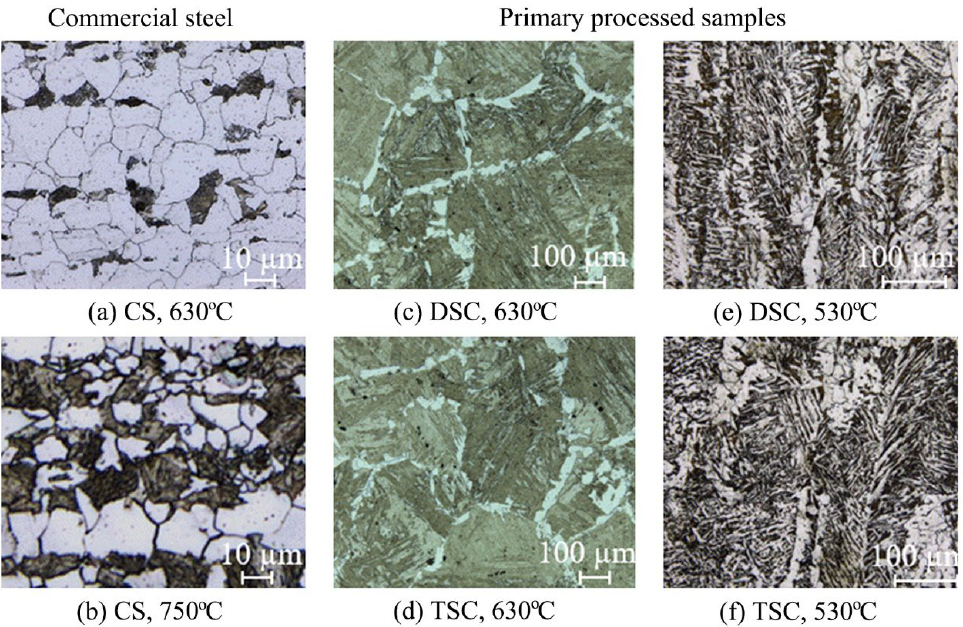
Figure 3. Typical microstructure for ( a , b ) benchmark processing study on commercial steel ( c , d ) primary processing treatment on direct strip cast and thin slab cast inter-critically annealed at 630 °C, ( e , f ) direct strip cast and thin slab cast heat treated at 530 °C. Heat treatment time is 300 s for primary treatment and 600 s for secondary treatments. Note higher magnification in ( a , b ). Microstructures from specimens subject to secondary heat treatment are shown in